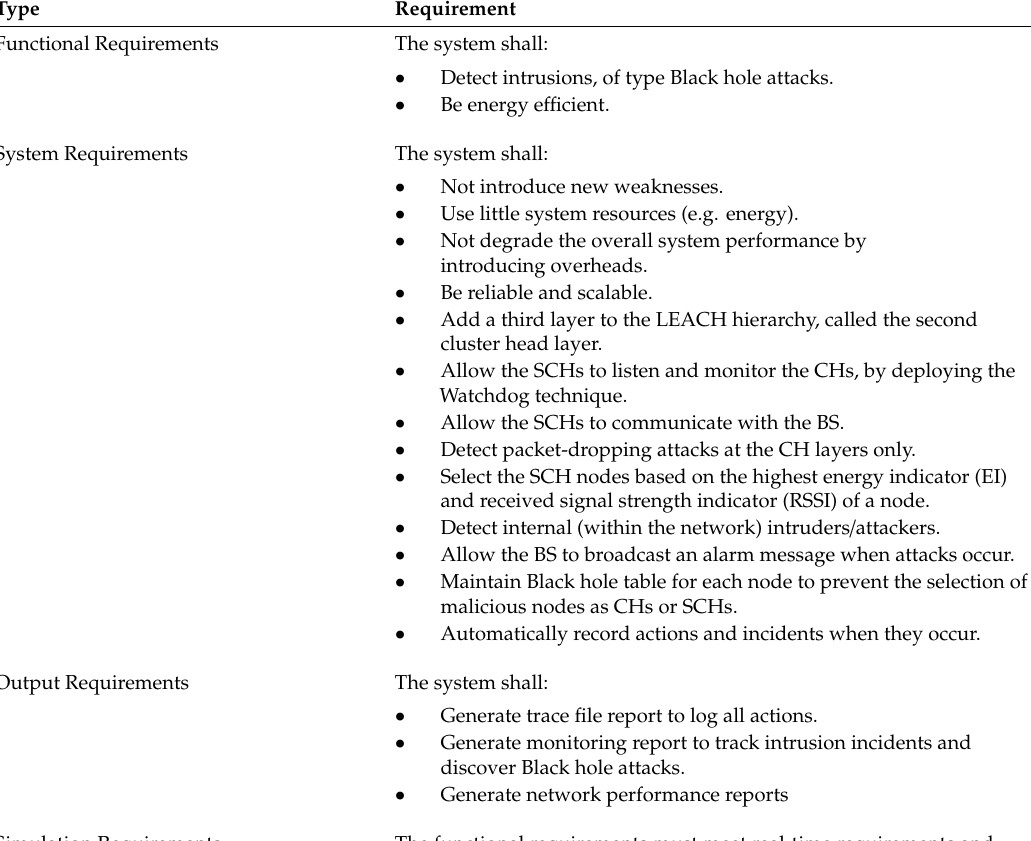
Table 3. Determine objectives and constraints.